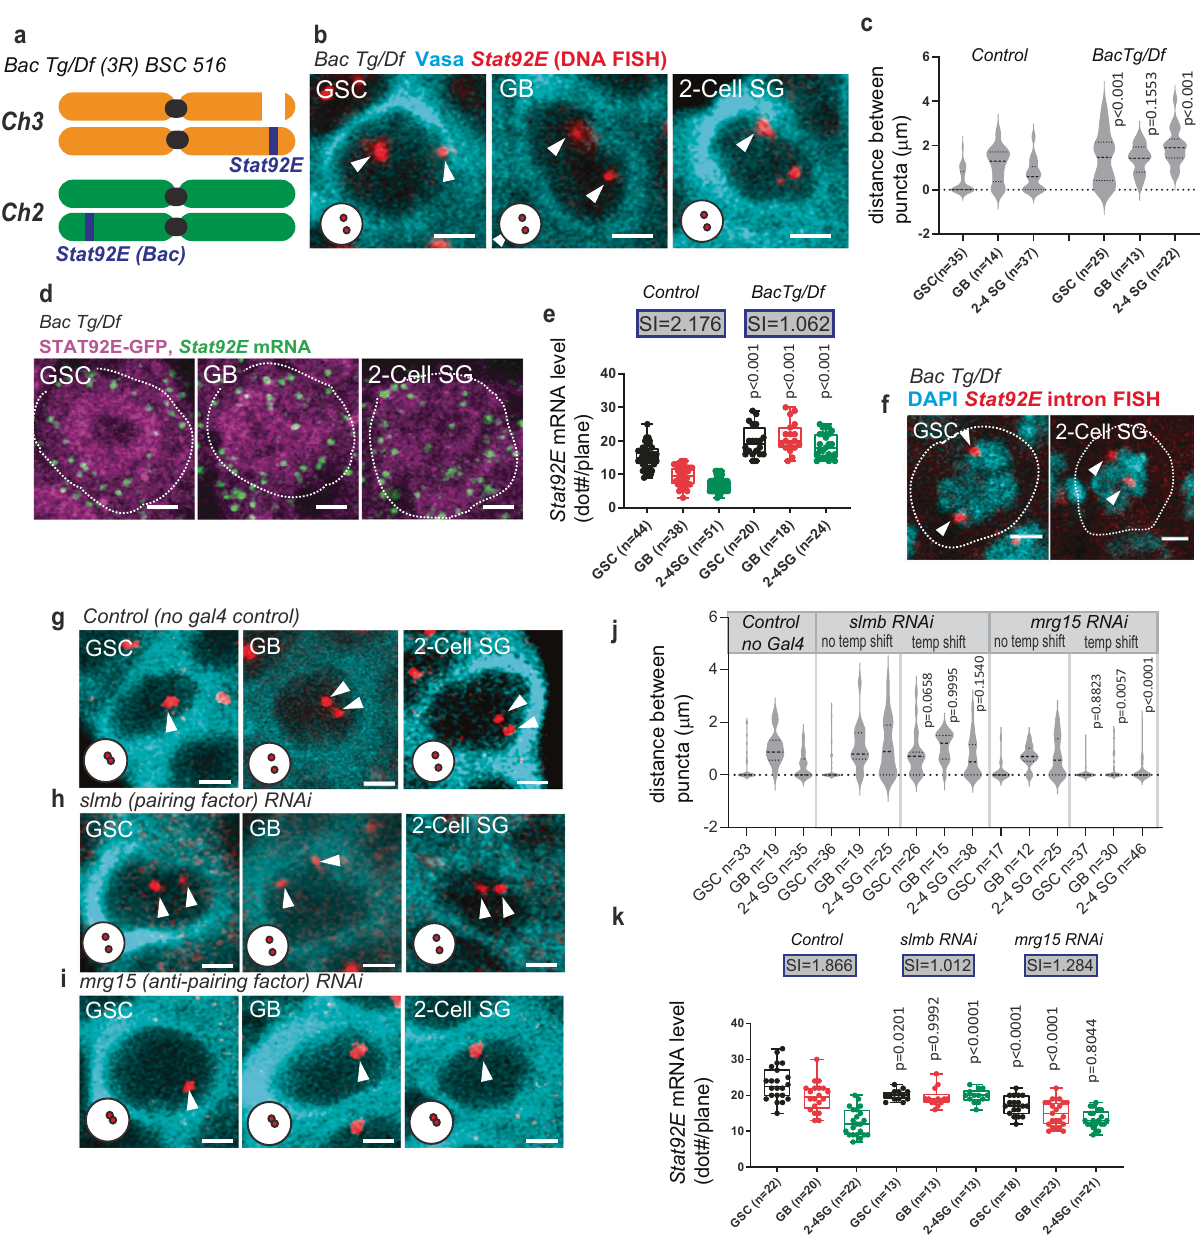
Fig. 4 The change in Stat92E pairing states is required for subsequent silencing of transcription. a A schematic of BacTg/Df(3 R)BSC516 ( BacTg/Df ) genotype. b Representative images of Stat92E DNA FISH puncta (red, white arrowheads) at the indicated stages of germ cells (Vasa, cyan) in